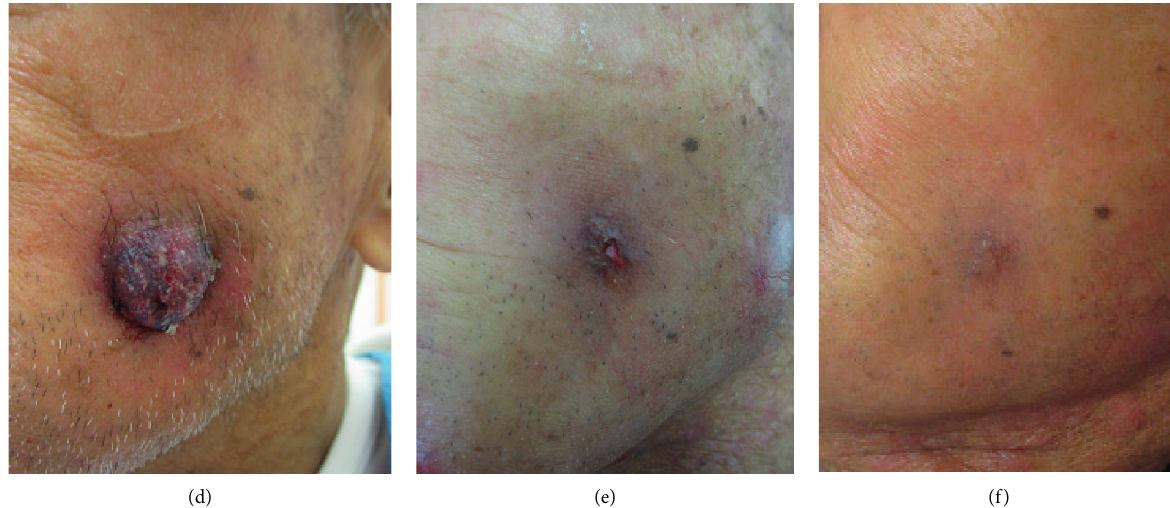
Figure 4: The response of cutaneous myeloid sarcoma (MS) to treatment with azacitidine. An MS located at the left groin before the first (6th in total) cycle of azacitidine retreatment (a). Before the second (7th in total) cycle (b). After the second cycle (c). An MS on the left cheek before the first cycle (d). Before the second cycle (e). After the second cycle (f). Table 1: The clinical characteristics of cases of myeloid sarcoma that were successfully treated with azacitidine. Case/